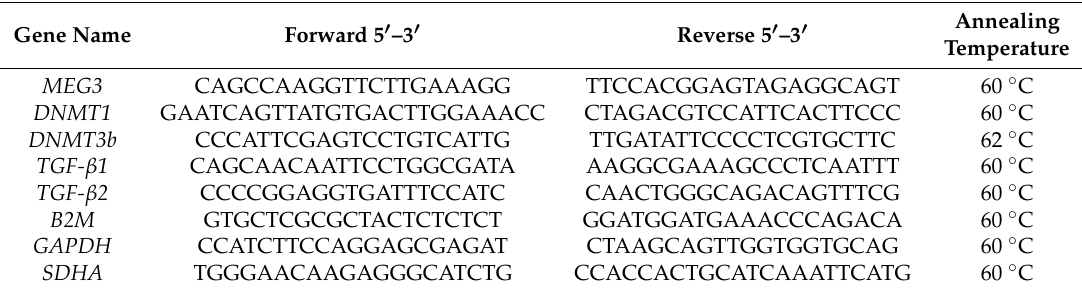
Table A1. Oligonucleotides used for